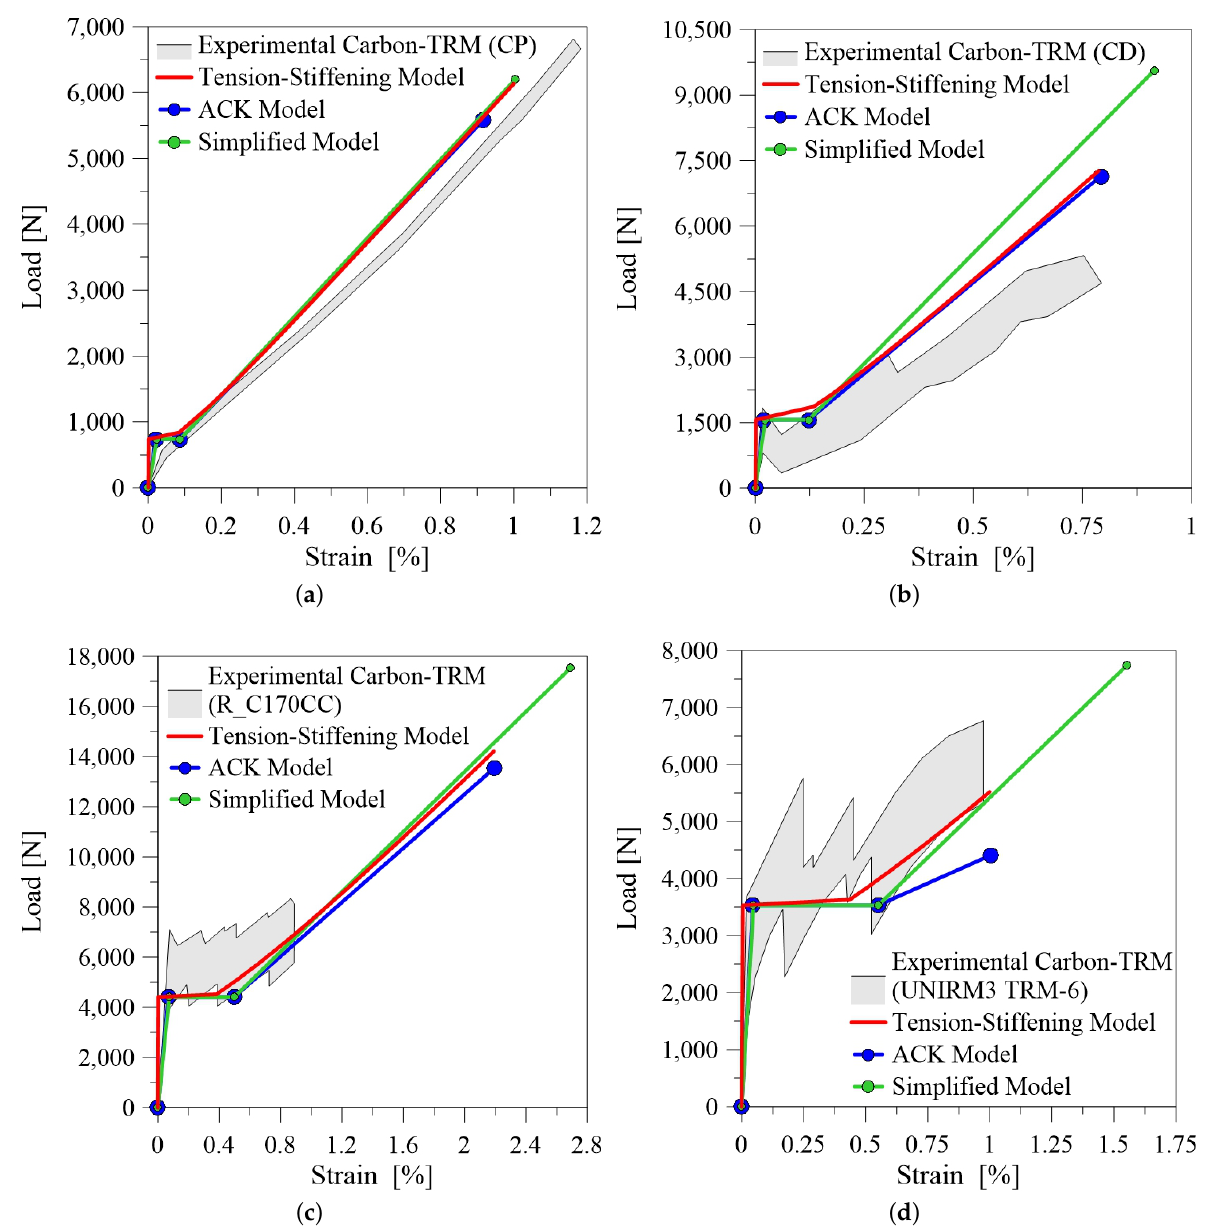
Figure 7. Comparison between experimental and analytical curves for carbon-TRM: ( a ) reference Bellini et al. [19] (CP); ( b ) reference Bellini et al. [19] (CD); ( c ) reference D’Antino and Papanicolaou [23] (R-C170CC); ( d ) reference Carozzi et al. [22] (FRCM 6